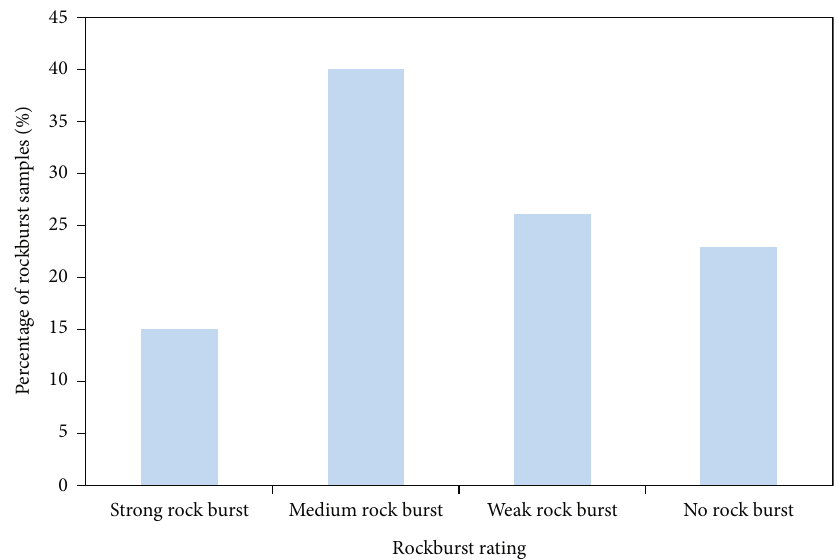
Figure 1: Proportion distribution of di ff erent rockburst